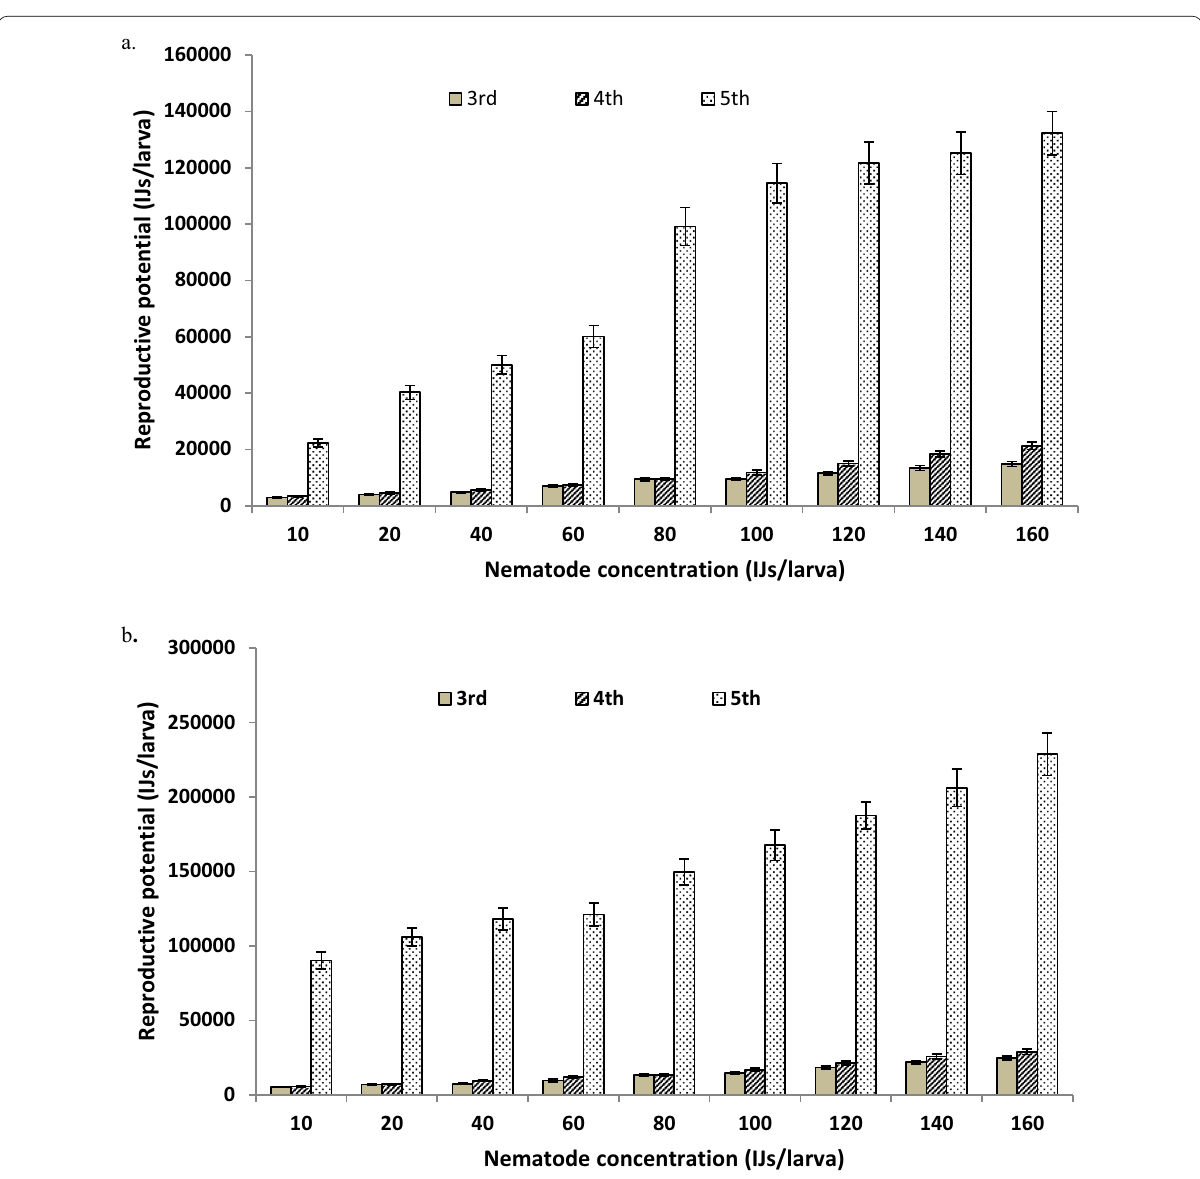
Fig. 3 Reproductive potential of H. indica strains on different larval instars of S. frugiperda in laboratory assay. Error bars indicate standard error of mean (SEM). a . CICR‑HI‑CL strain, b . CICR‑HI‑MN strain. No significant difference was observed across concentrations in reproductive potential of 3rd and 4th instar, however 5th instar differed significantly at P 0.01 level of ≤